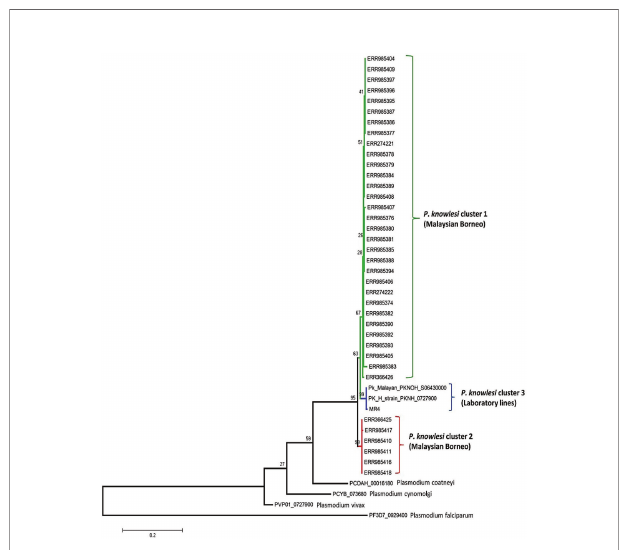
FIGURE 4 | Phylogenetic tree of PkRhopH2 proteins (cross-protective domain, aminoacid positions22 – 387) from clinical samples of Malaysia and its orthologs inother Plasmodium species is constructed basedonthe maximum likelihood method.Cluster 1 and cluster 2 represent the two subpopulationsof clinical samples fromMalaysian Borneo, and the 3 rd cluster contains lab strainsof P. knowlesi . Bootstrapvalues are indicatedby numbersat